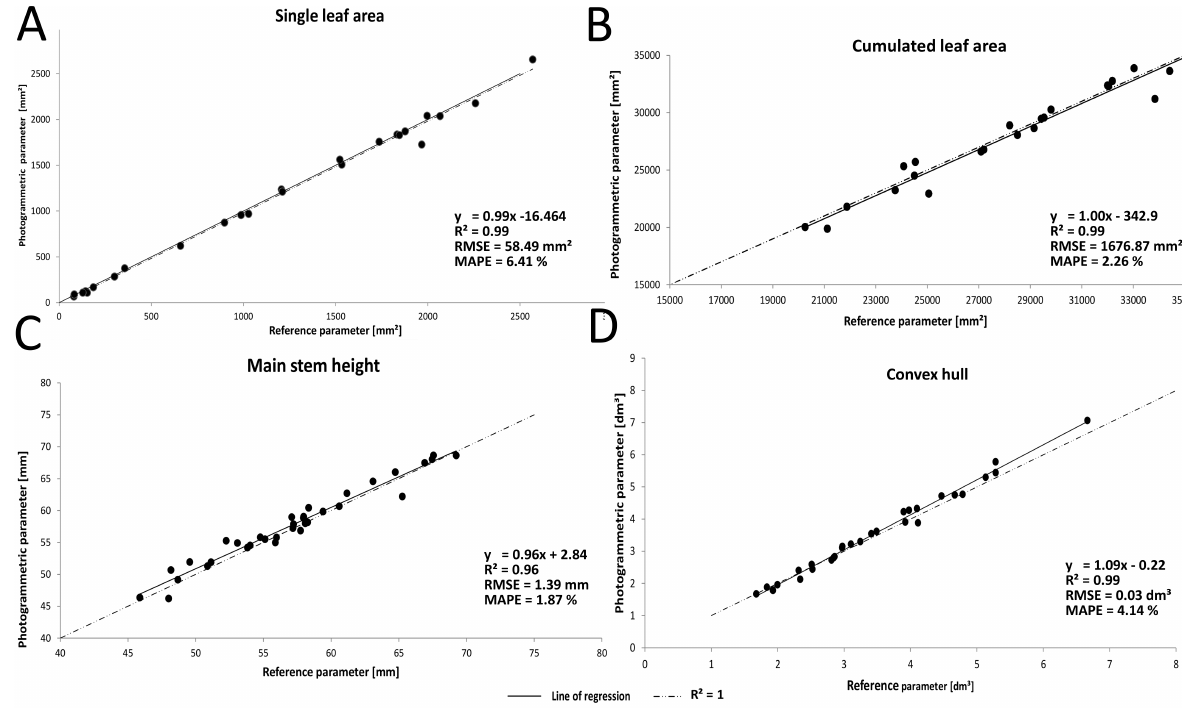
Figure 5. Regression analysis, RSME and MAPE results for the extracted parameters. ( A ) Single leaf area; ( B ) cumulated leaf area; ( C ) main stem height; ( D ) convex